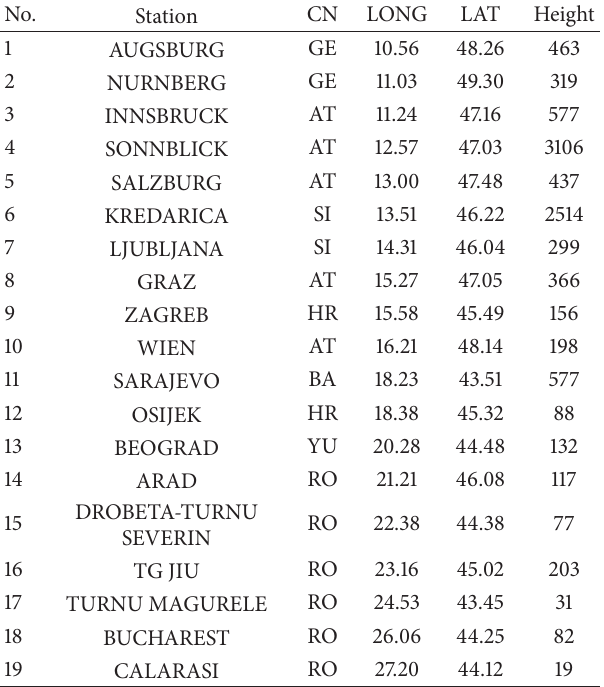
Table 1: Geographical information about the analysed